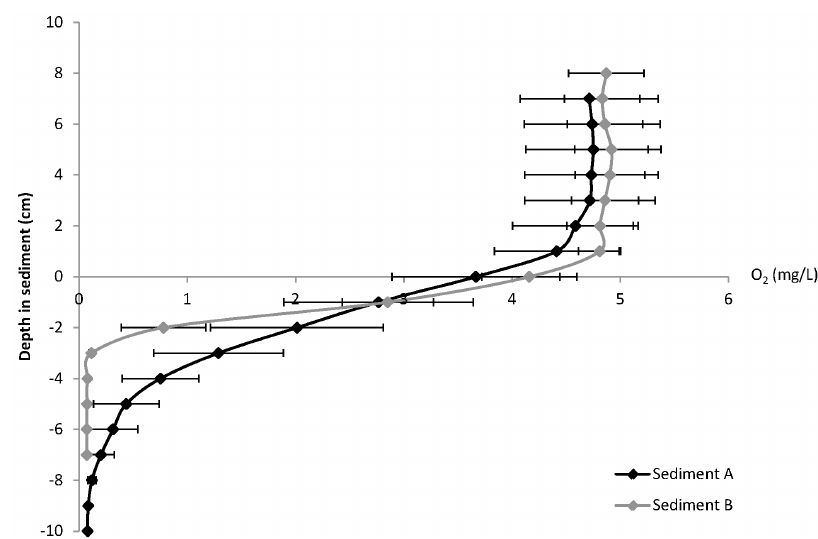
Figure 4. Oxygen (O 2 ) concentration (mg L 2 1 ) profile per mm of both sediments (A and B), at the sediment-water interface (indicated by vertical dotted line) during aerobic and anaerobic conditions.